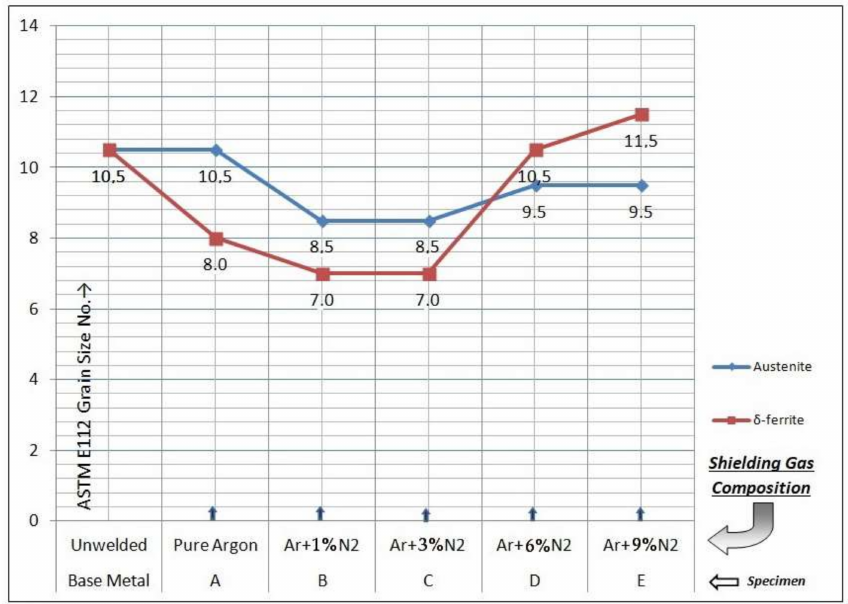
Figure 10. The effects shielding gas composition on phases grain size.